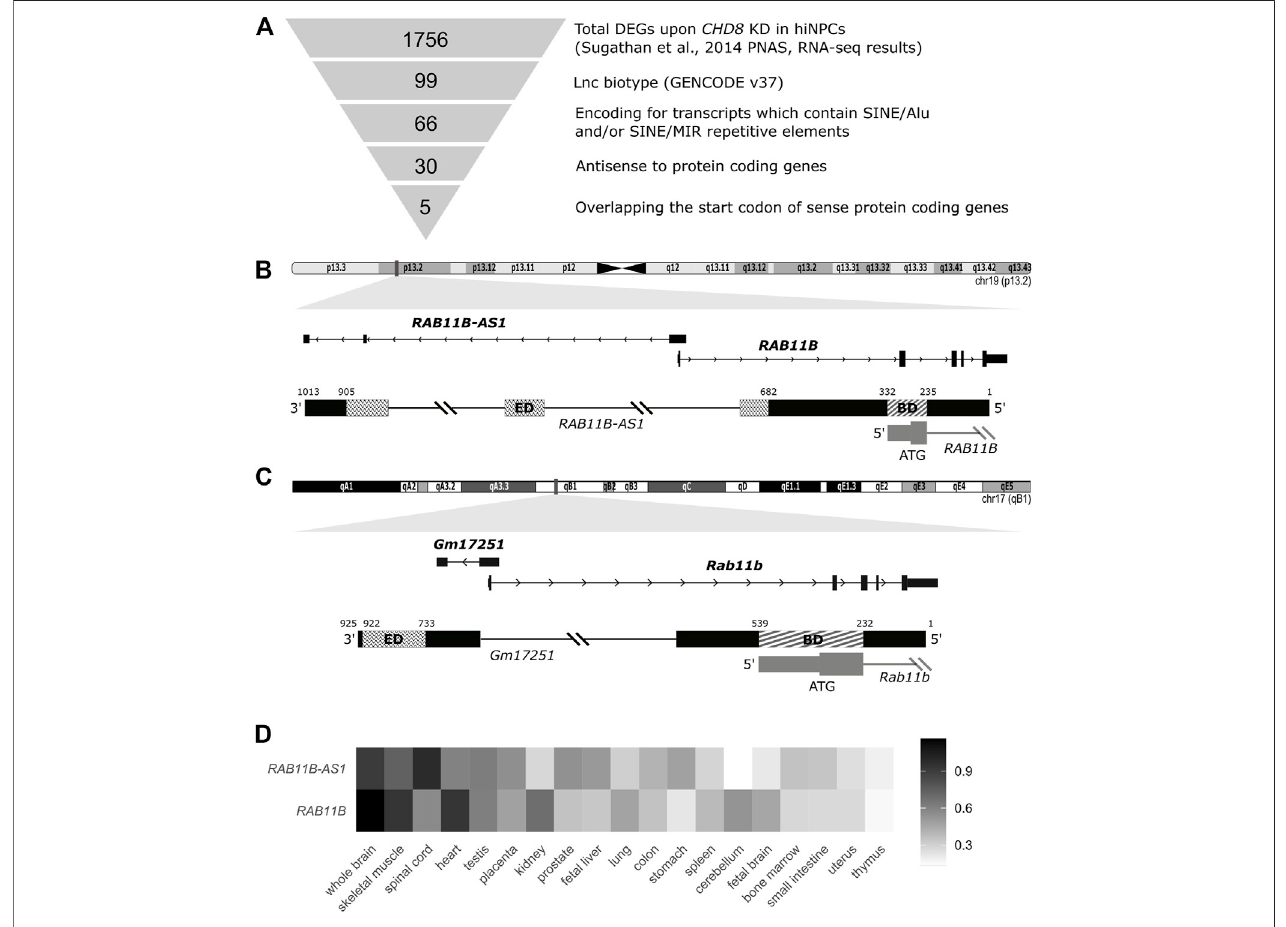
FIGURE 1 | Identi fi cation of SINEUP-like molecules among deregulated transcripts following CHD8 suppression. (A) Schematic representation of the employed pipeline,withsequential fi lteringstepsfortheselectionofcandidateSINEUP-likemolecules. (B) IntegrativeGenomeViewer(IGV)viewofthecandidateantisenselncRNA RAB11B-AS1 and the respective sense counterpart coding mRNA RAB11B (Human RefSeq annotation). Putative SINEUP functional domains are highlighted (Binding Domain, BD) (Effector Domain, ED). (C) IGV track for M. musculus RAB11B-AS1/RAB11B transcripts orthologues, respectively, Gm17251 and Rab11b . Putative functional domains are conserved and highlighted (BD) (ED). (D) Heatmap depicts normalized expression levels (2 − ΔΔ Cq ) of RAB11B and RAB11B-AS1 , illustrating concordant expression across human tissues, with highest levels reported in black and lowest in white.